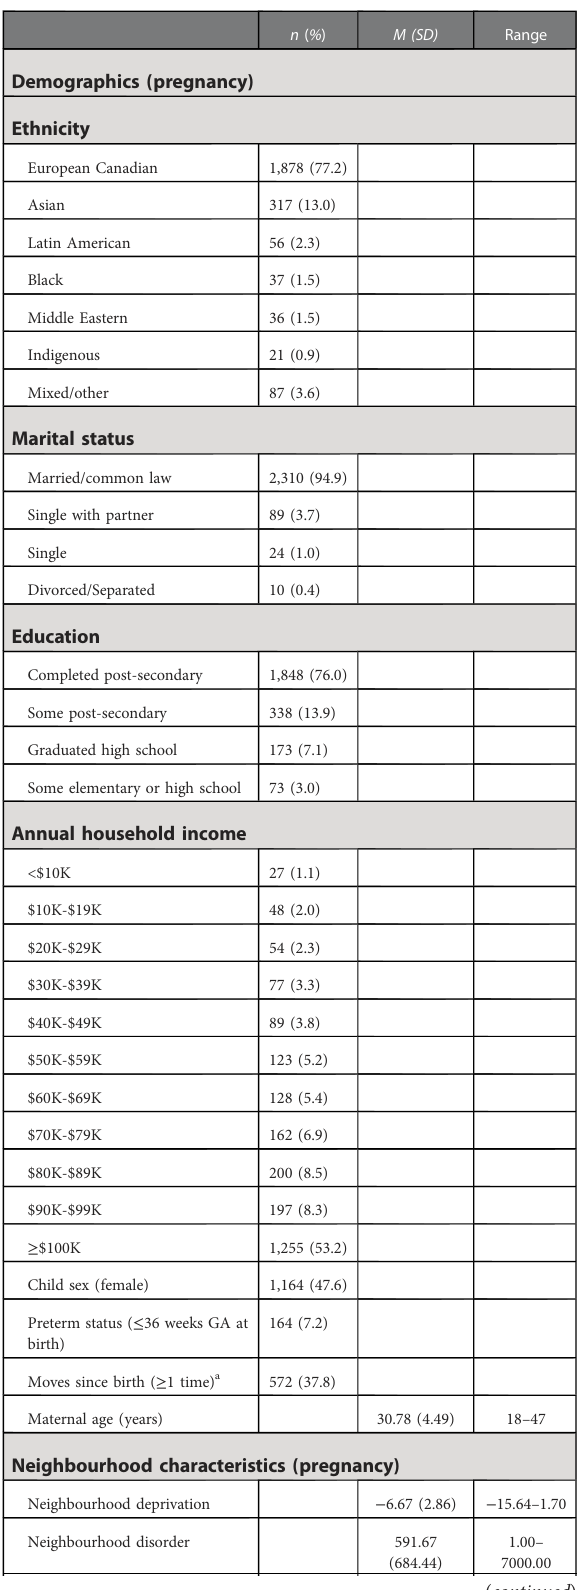
TABLE 1 Descriptive statistics for study variables ( n